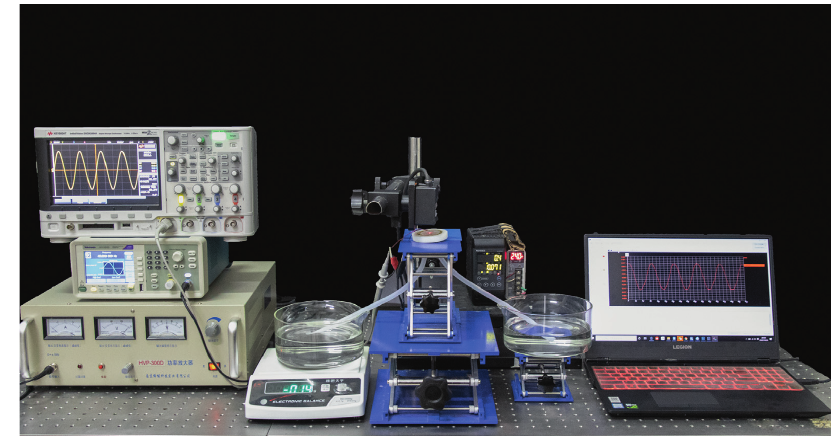
Figure 6: Traffic test